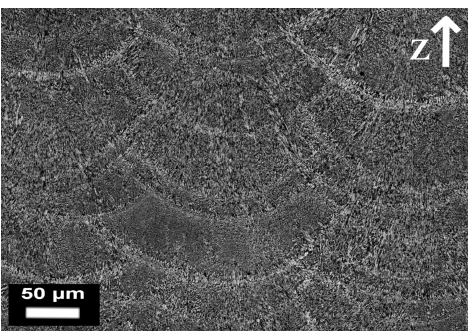
Figure 8. Optical micrographs of AlSi10Mg samples produced by means of Direct Metal Laser Sintering (DMLS) using a unidirectional scanning strategy (along the x axis). This strategy produces parallel scan tracks inside the material, and melt pools with an almost half cylindrical shape can be detected in a cross section parallel to the zy plane.